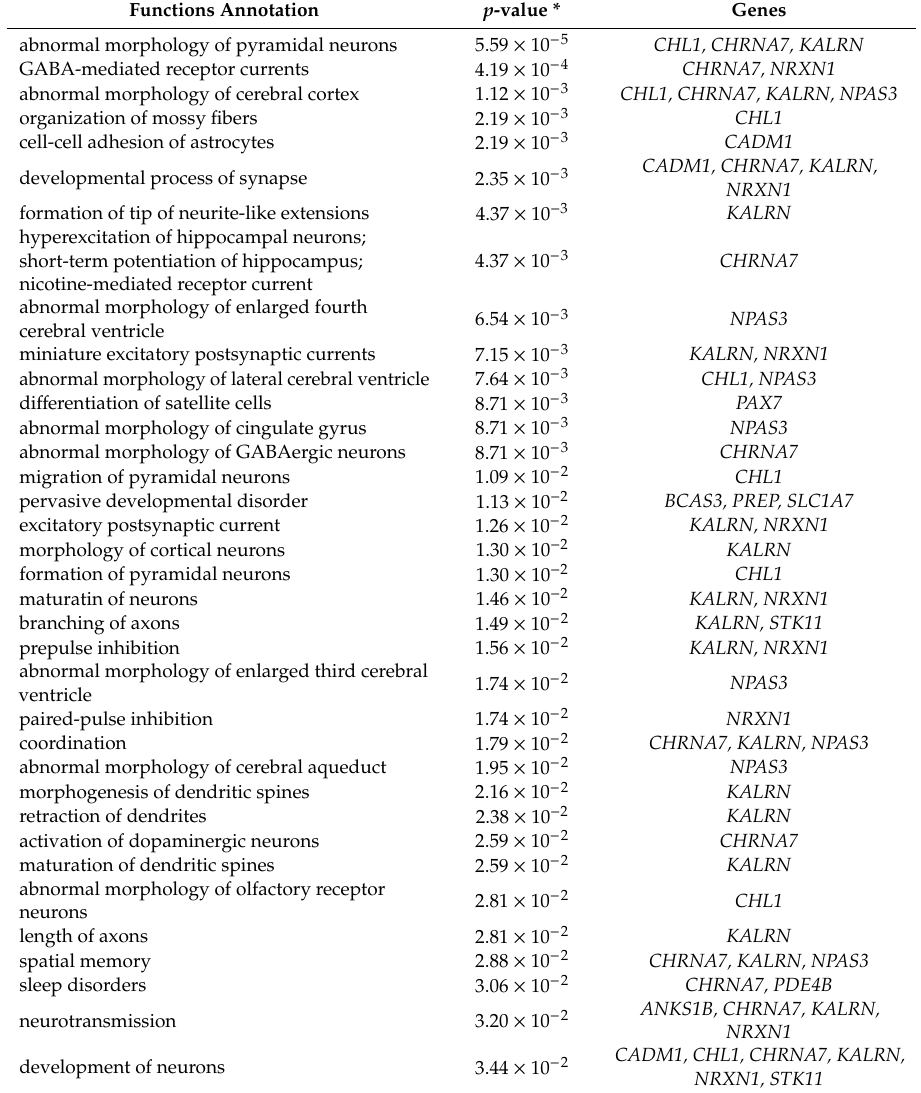
Table 9. Neurological functions implicated by QTN-associated genes in